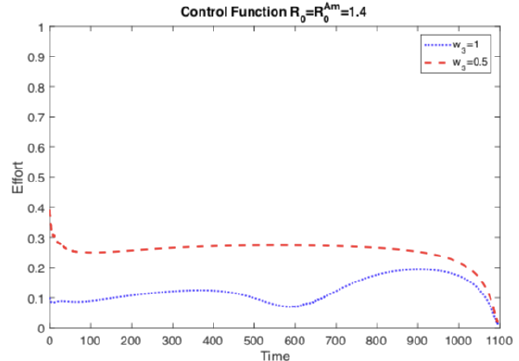
Figure 4. As the relative cost of the control function decreases, it is used more frequently and is able to control the outbreak. If the relative cost is expensive, then it is used sparingly and in response to outbreaks. Notice the peaks occur right after an increase in the prevalence of dengue in the corresponding panel of Figure